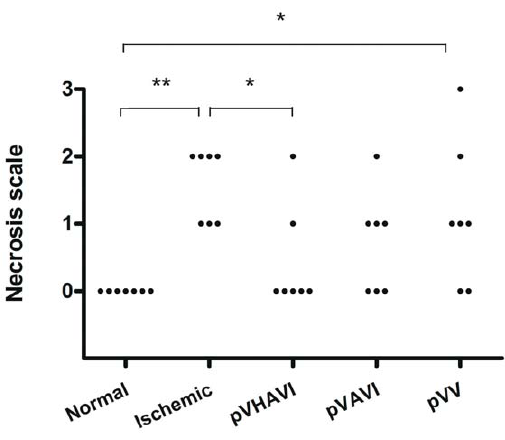
Figure 3. Visual assessment of ischemic limbs after gene therapy. Four weeks after gene therapy, limbs were evaluated according to the following necrosis scale: grade 0: absence of necrosis; grade I: necrosis limited to the toes; grade II: necrosis extending to the dorsum pedis, grade III: necrosis extending to the crus. * P , 0.05; ** P ,